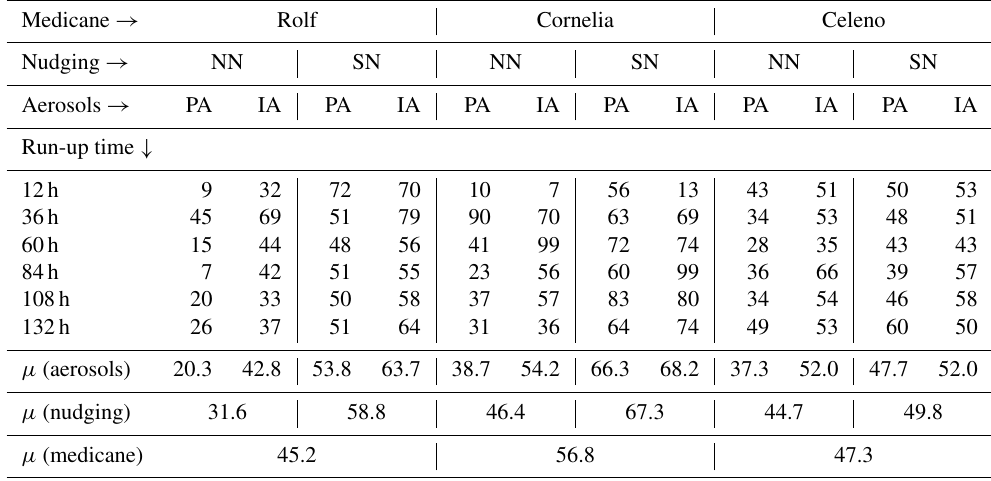
Table 2. Summary of the medicane duration – number of points in the compact set – of the 72 simulation ensembles. The µ quantity reduces the ensemble through the sample mean for each aggregated recursive